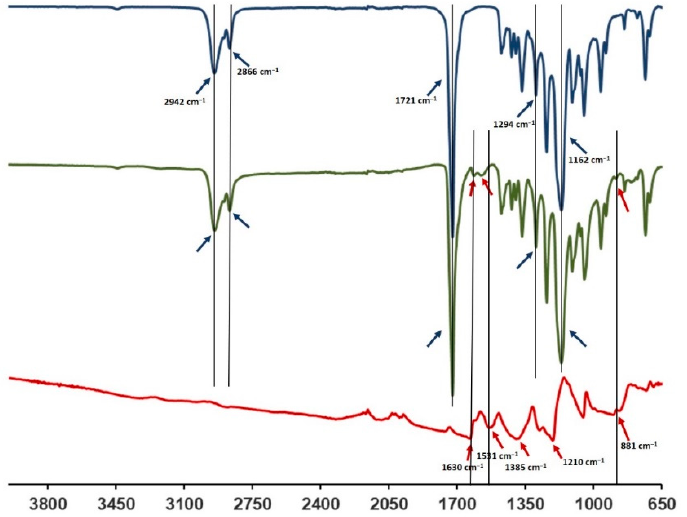
Figure 3. FTIR spectra of PANI-CSA (red), PCL-PANI (green) and PCL (blue).